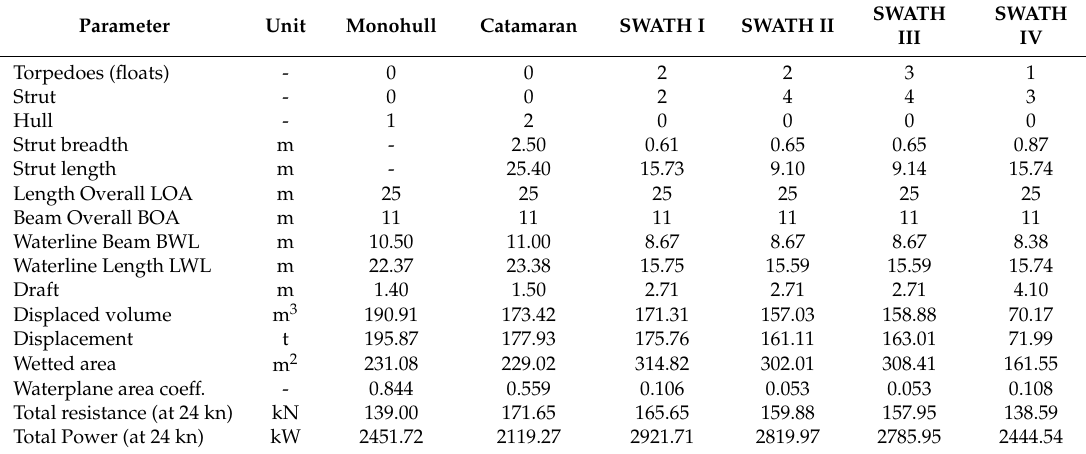
Table 2. Comparison of design parameters of Monohull / Catamaran / SWATH craft types.